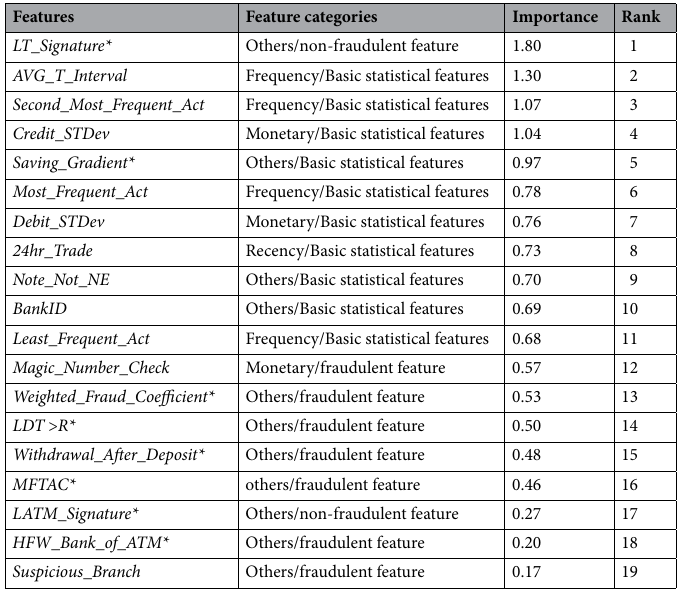
Table 3. Feature importance. Features marked with “*” are unique features in our model and features listed as “Other” are not RFM or FBADT features. (FBADT features do not appear here because the scores are too low and they are not included in